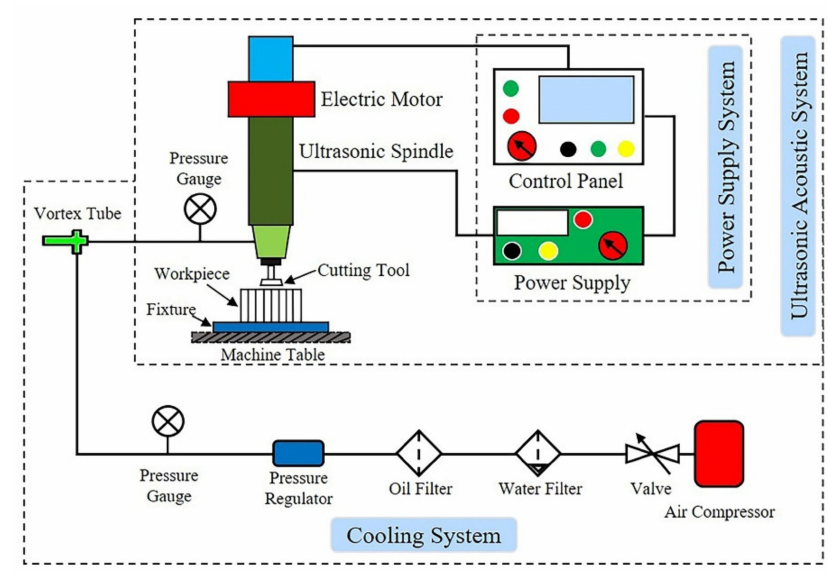
Figure 1. Abridged general view of RUM system for HCs core.